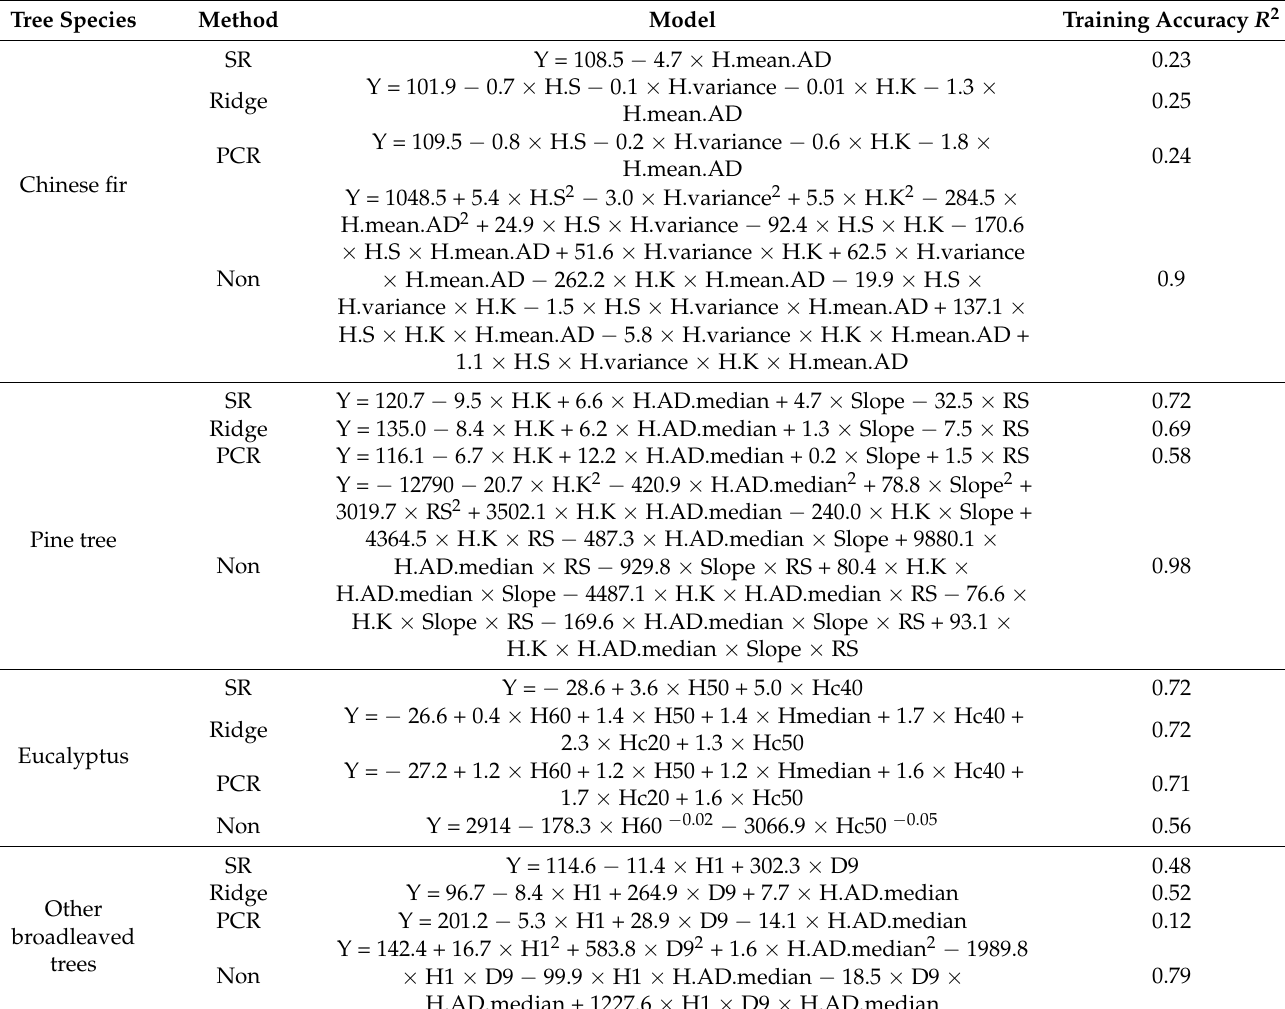
Table 8. Different regression models and training